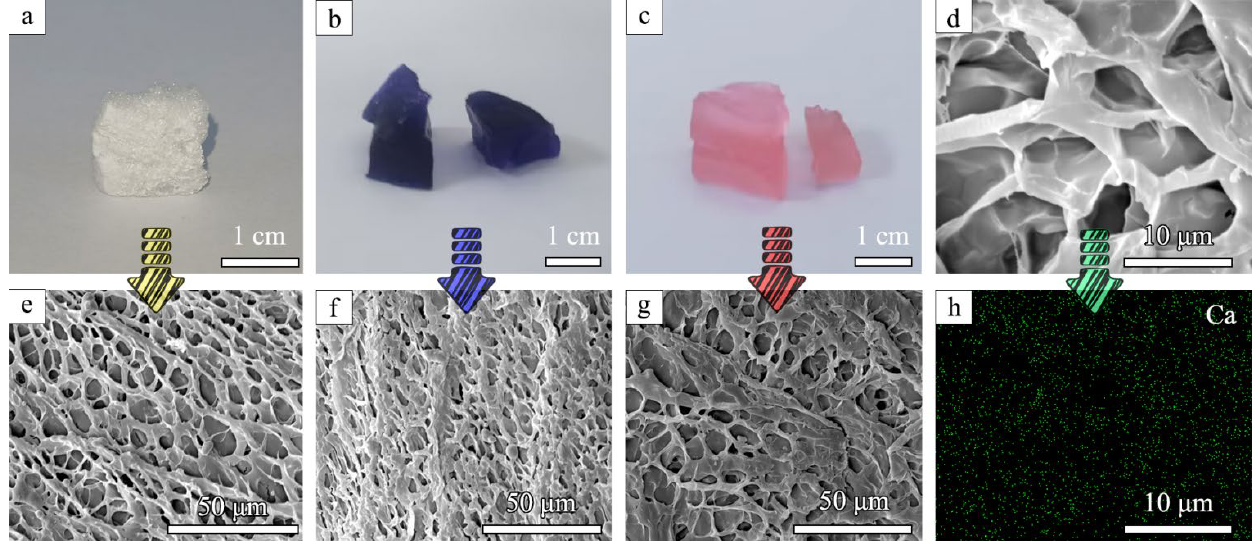
Figure 1. Digital photos of the ( a ) CaCO 3 @STA/PAM/TOCN aerogel; ( b ) CaCO 3 @STA/PAM/TOCN aerogel after adsorption of methylene blue; ( c ) CaCO 3 @STA/PAM/TOCN aerogel after adsorption of Congo red; SEM images of the ( d , e ) CaCO 3 @STA/PAM/TOCN aerogel; ( f ) CaCO 3 @STA/PAM/TOCN aerogel after adsorption of methylene blue; ( g ) CaCO 3 @STA/PAM/TOCN aerogel after adsorption of Congo red; ( h ) EDX mapping images of the CaCO 3 @STA/PAM/TOCN.